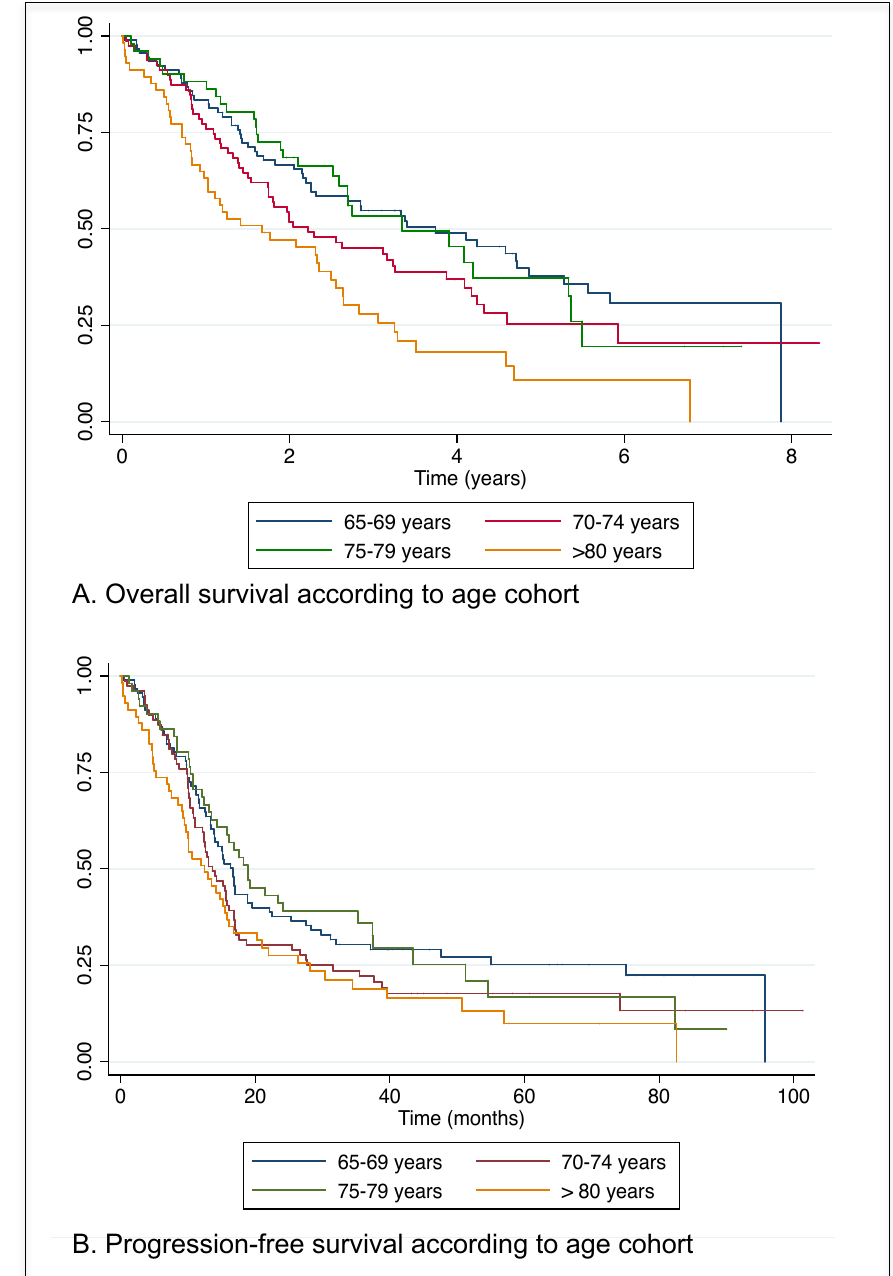
Figure 2. ( A ) Overall survival according to age cohort. ( B ) Progression-free survival according to age